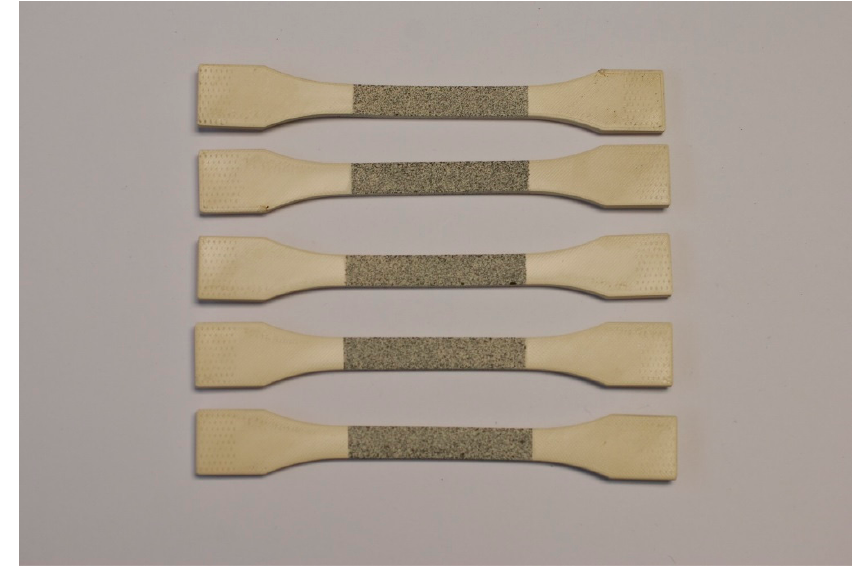
Figure 7. Printed samples for tensile test.